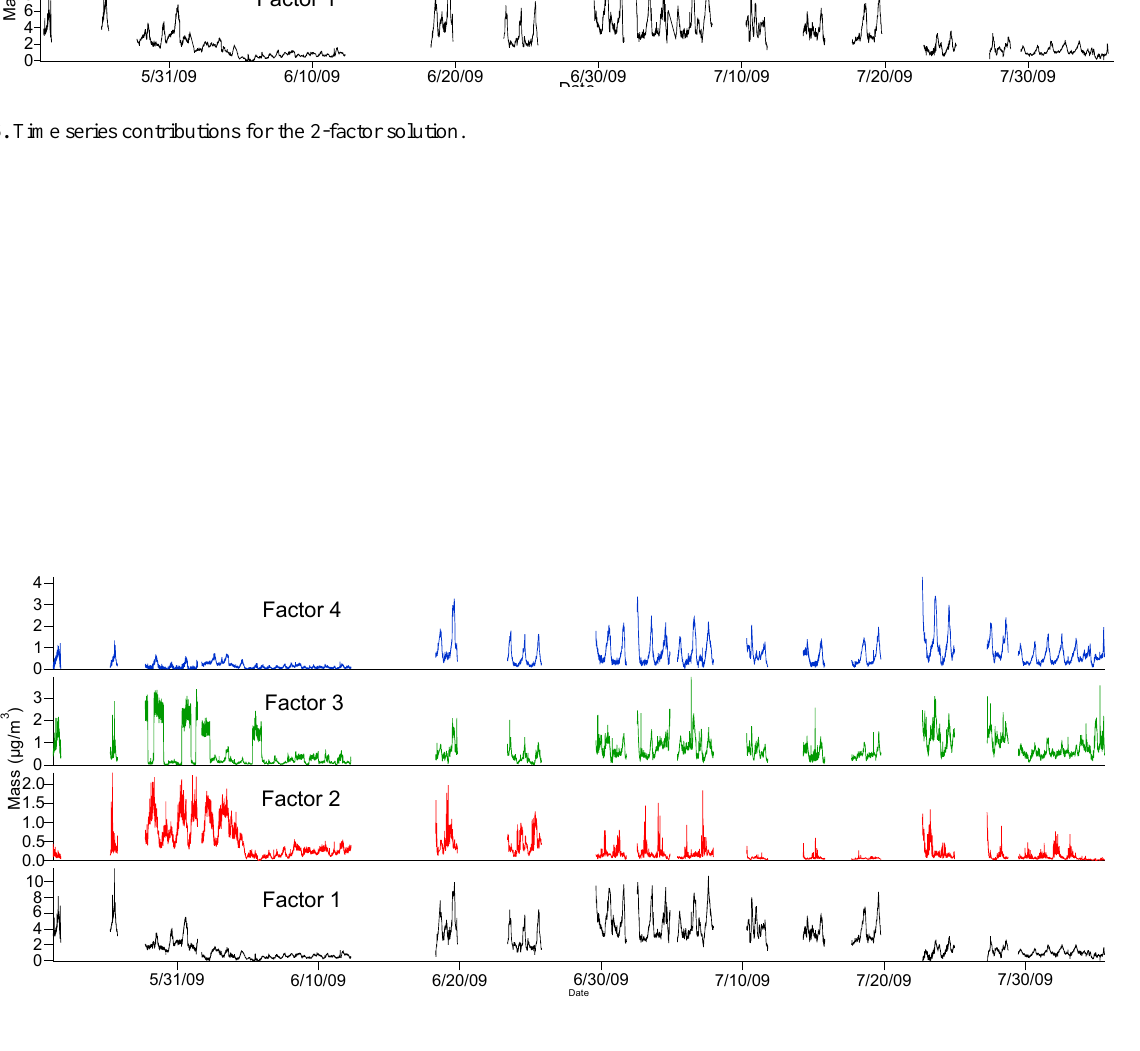
Fig. A7. Time series contributions for the 4-factor solution.